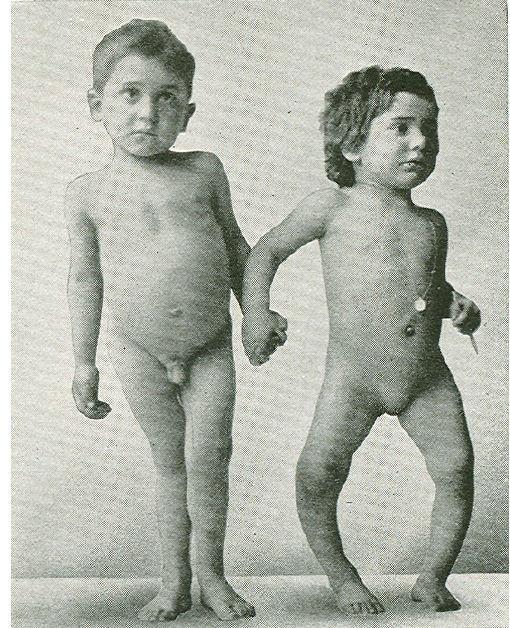
Figure 4. Sister (right) and brother (left) ages 4 years and 6.5 years,